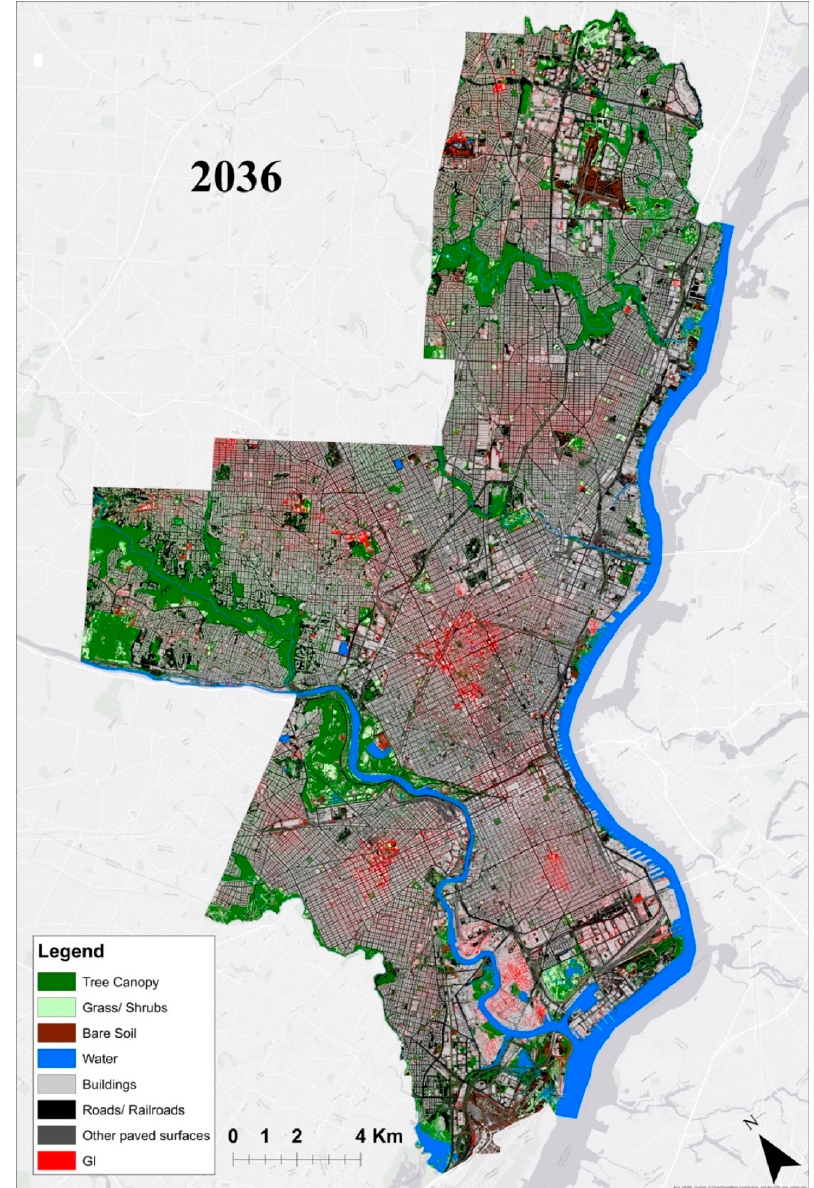
Figure 4. The predicted landcover of Philadelphia in 2036 under green infrastructure policies.